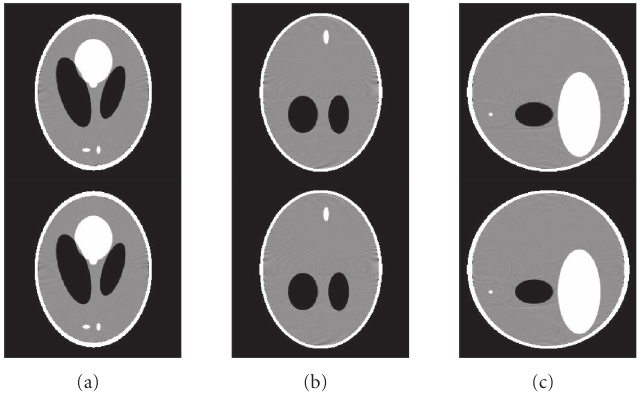
Figure 6: (a) Slice: x 3 = − 0 . 255; (b) slice: x 2 = − 0 . 067; (c) slice: x 1 = − 0 . 067. Top: reconstructed image by Algorithm 1; bottom: recon- structed image by Algorithm 2. Since the computation of image reconstruction in Algorithm 2 is same as that in Algorithm 1, the images reconstructed by Algorithm 2 are same as those by Algorithm 1.